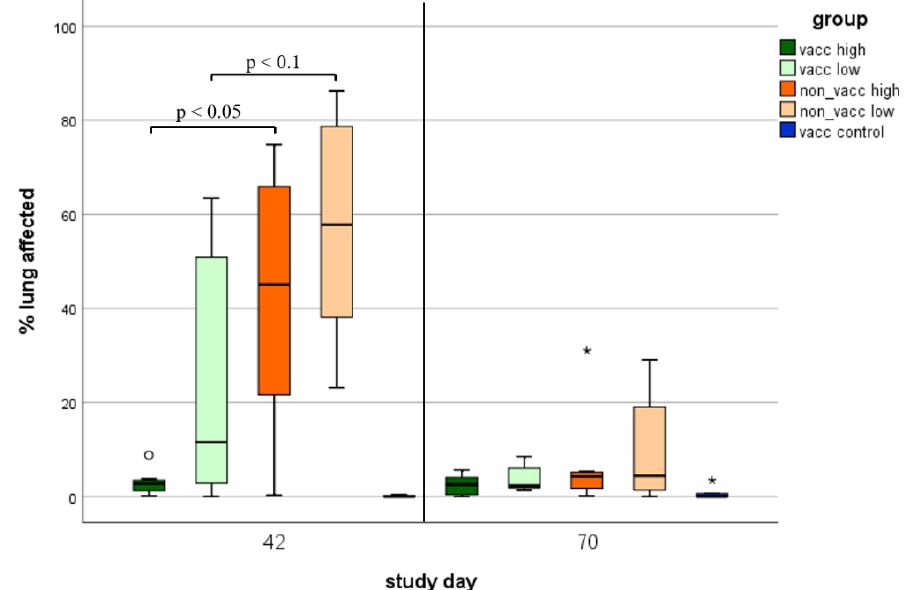
Figure 8. Macroscopic lung lesions. Total lung lesion score (corresponding to % of lung affected) of animals necropsied on either study day 42 (first necropsy) or study day 70 (second necropsy) in each group (vacc high: vaccinated, high dose [10 5 TCID 50 /dose] infected; vacc low: vaccinated, low dose [10 3 TCID 50 /dose] infected; non-vacc high: non-vaccinated, high dose infected; non-vacc low: non-vaccinated, low dose infected; vacc control: vaccinated, non-infected). Boxplots show 25th and 75th percentiles and median values, and whiskers show minimum and maximum values within 1.5 × interquartile range (IQR). Outliers are values with more than 1.5 × IQR (indicated using circles ◦ ), and extreme values are values with more than 3 × IQR (indicated using asterisks *). P -values < 0.1 are indicated using